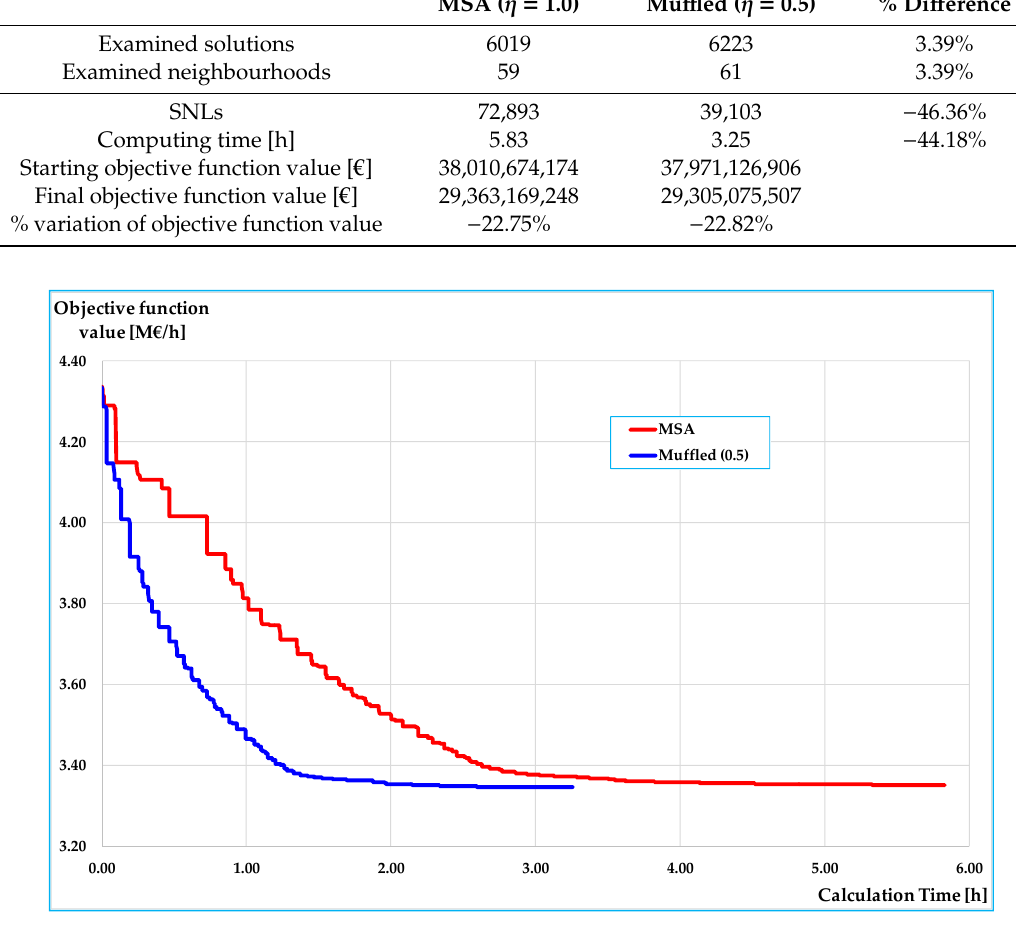
Figure 9. Comparison between algorithms in terms of computing times vs. objective function